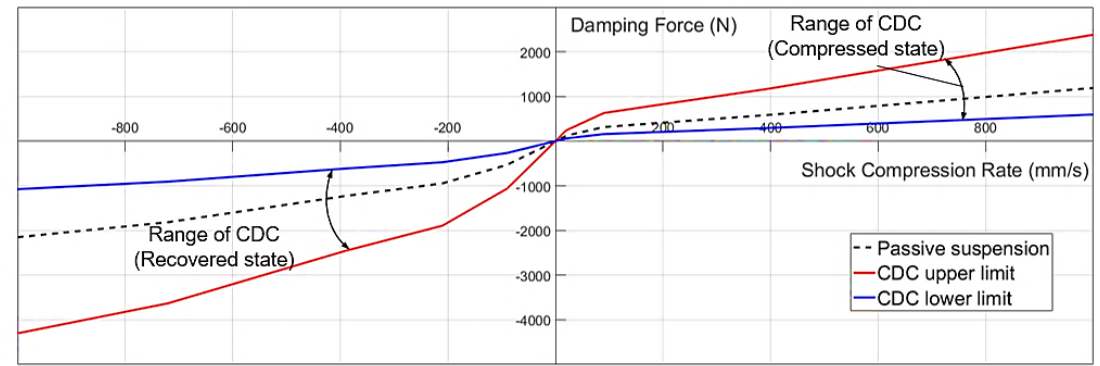
Figure 6. Range of variation of continuous damping control (CDC) damping force.